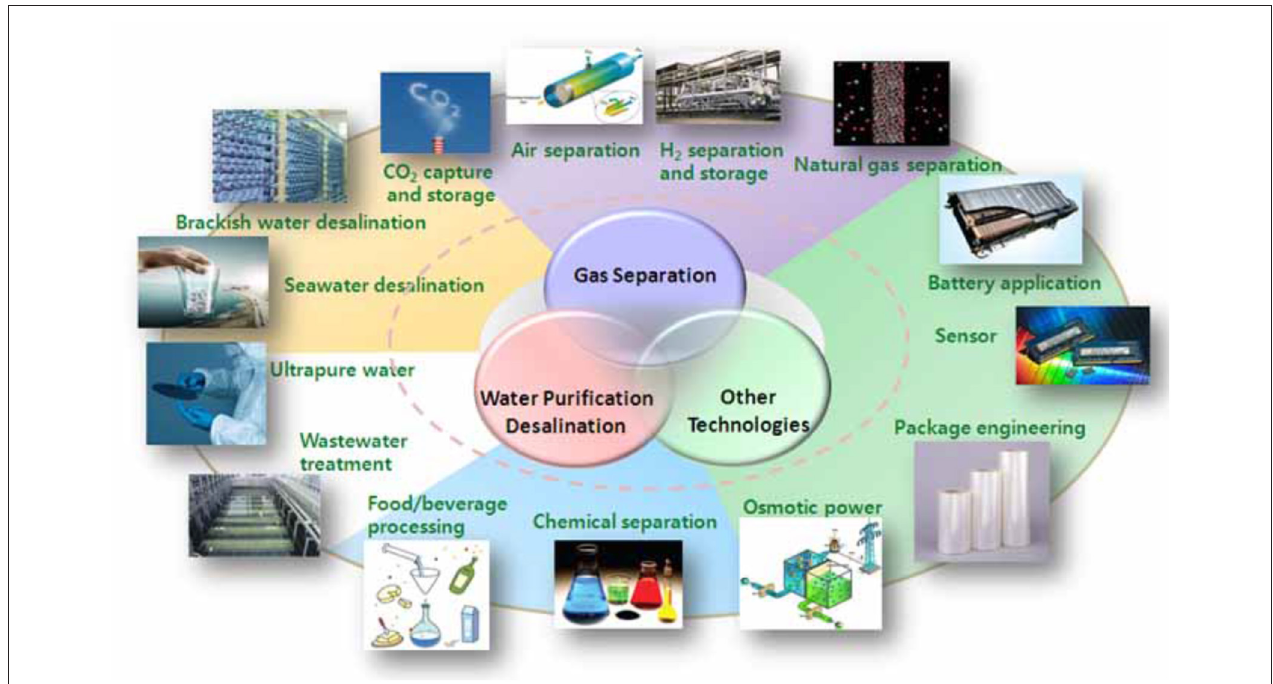
FIGURE 4 | Overview of graphene applications in various sectors (from https://www.pgmcapital.com/why-investing-in-graphene-can-be-lucrative/).